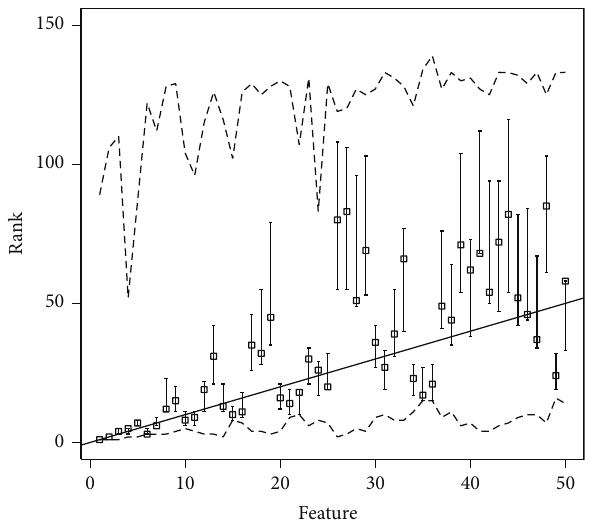
Figure 2: Supports (dashed lines), modal points (bars), fuzzy ranks (abscissa), and crisp ranks (ordinate of the squares) of the 50 most relevant metrics. Those metrics whose square is plotted below the diagonal line occupy a more relevant position under the fuzzy rank.